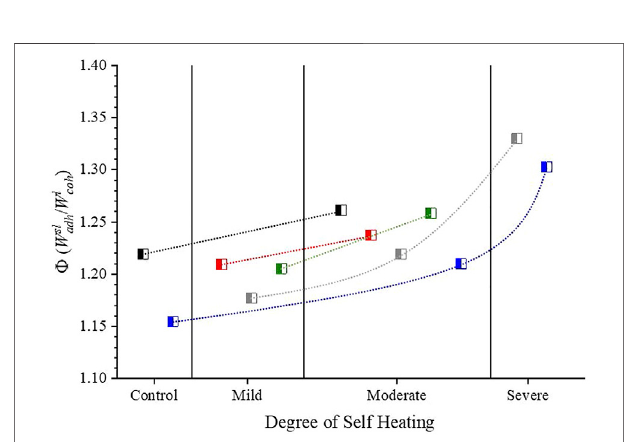
FIGURE 9 | The ratio of the work of adhesion, W sl adh , and work of cohesion of water, W l coh , is plotted as a dimensionless value denoted by “ Φ . ” Dottedlineshavebeenaddedtoassistthereaderincomparingsamplesofthe same bale; 2 Bale 1, 2 Bale 2, 2 Bale 3, 2 Bale 5, 2 Bale 6.